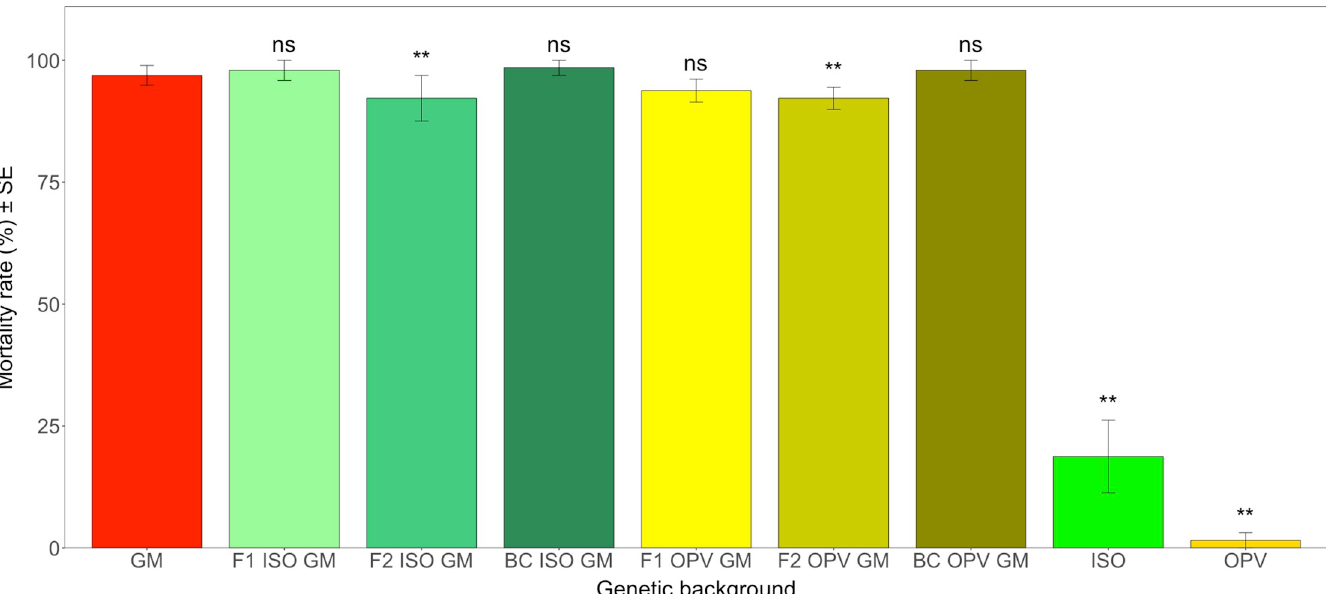
Fig 6. Mean mortality rate (%) of H . armigera in different genetic backgrounds from Brazil. Vertical bars show mean values, with standard error ( ± SE) indicated with lines. Results of multiple comparisons of means with the group control GM parental maize (Dunnett’s method). �� P < 0.01, ns = not significant. The p-values reported were adjusted by the single-step